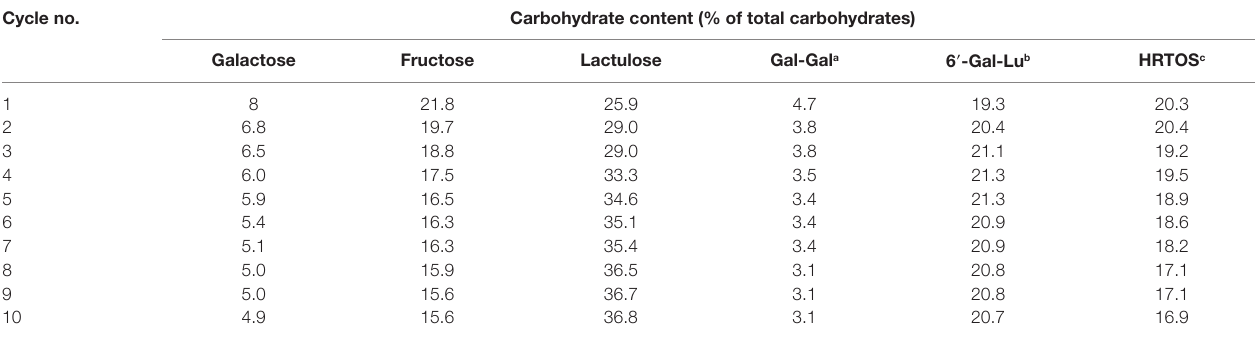
TaBle 2 | effect of the multiple use of the A. oryzae β -galactosidase immobilized (16 U/ml) on a support of glutaraldehyde–agarose on the carbohydrate content obtained by hydrolysis of 450 g/l lactulose in buffer sodium phosphate 0.1M ph 6.5, at 50 °c after 7 h of reaction. cycle